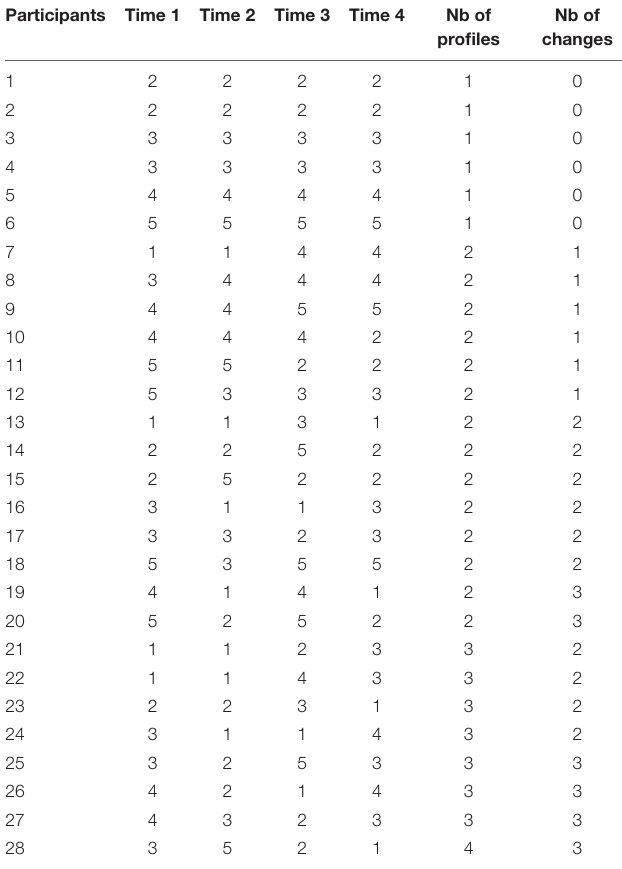
TABLE 3 | Individual fluctuations for each of the participants in the four